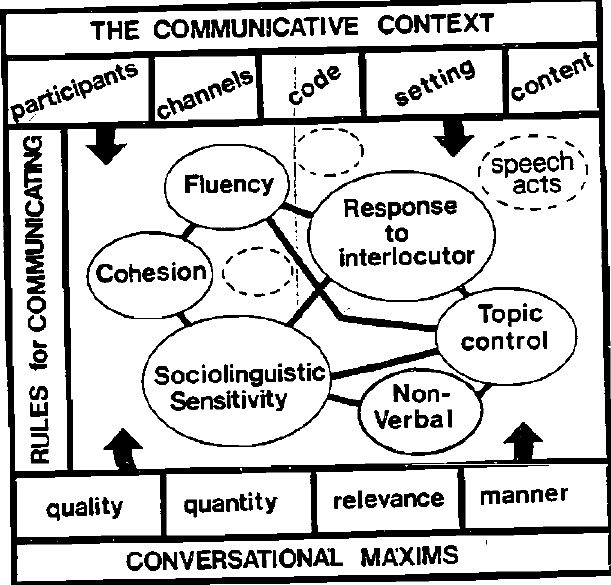
Figure 1 The Realm of Pragmatics